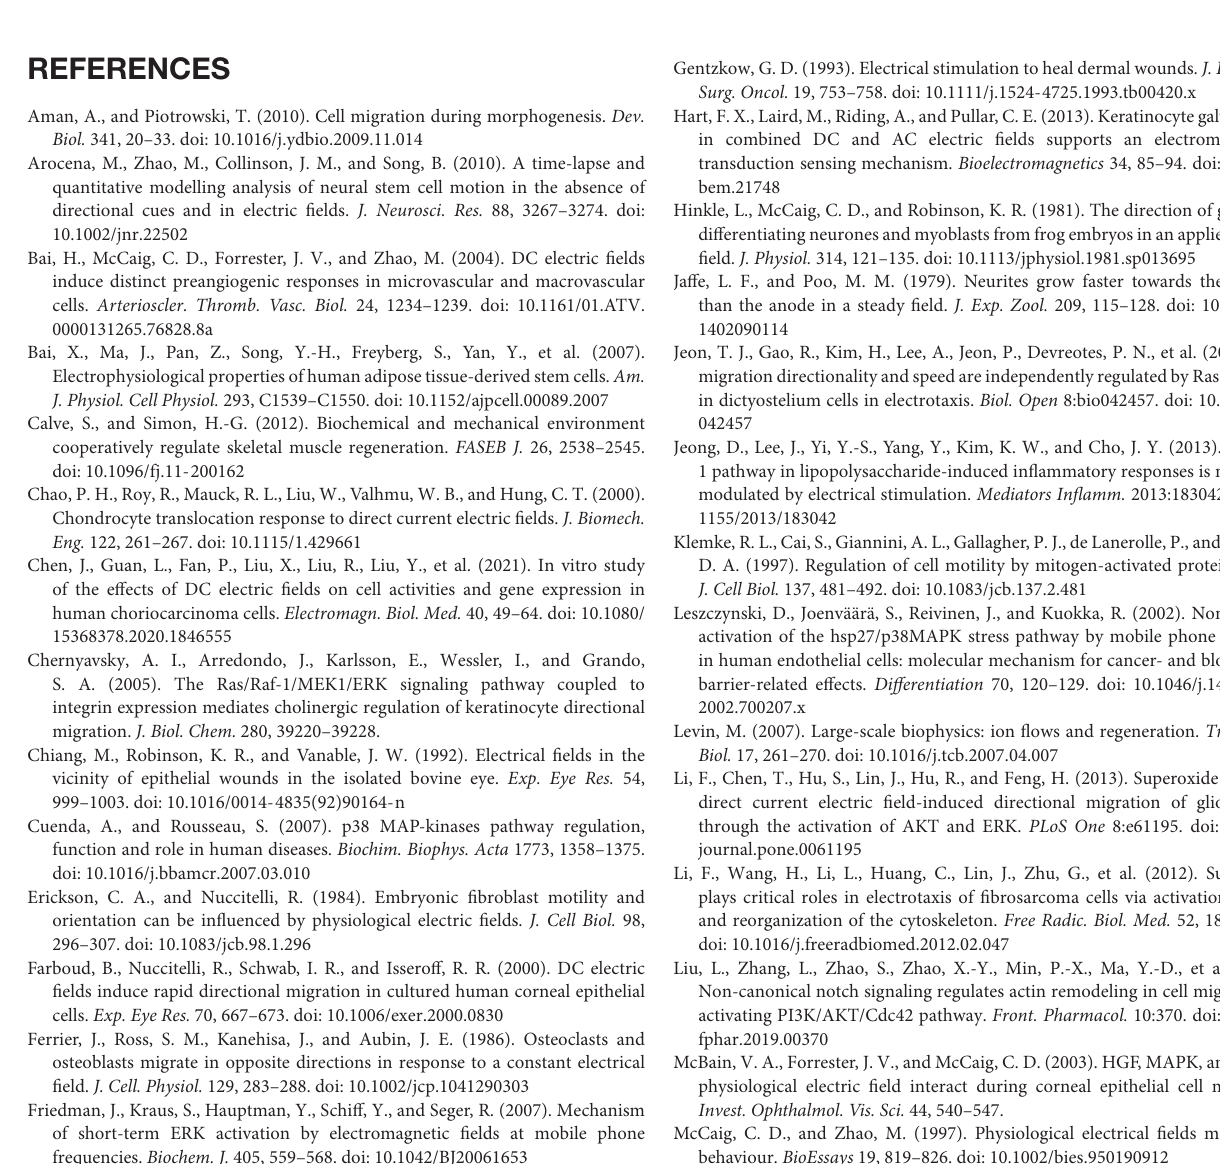
center of the culture) (A) . Polarity is as indicated; the cathode is at right. Bottom panels show the outlines of the wounded monolayers front at the beginning and end of each experiment with migration direction indicated by the arrows. Scale bar = 200 µ m. ∗ P < 0.05, compared to the same edge of the control with no EF (0 mV). (F) Quantification of the cell migration distance of wound edges (left, cathode facing side) in different treatment groups. Supplementary Video 1 | Real-time imaging of live cells showing cathodal migration and enhanced motility of human renal tubular epithelial cells in culture exposed to an EF of 200 mV/mm (over 6